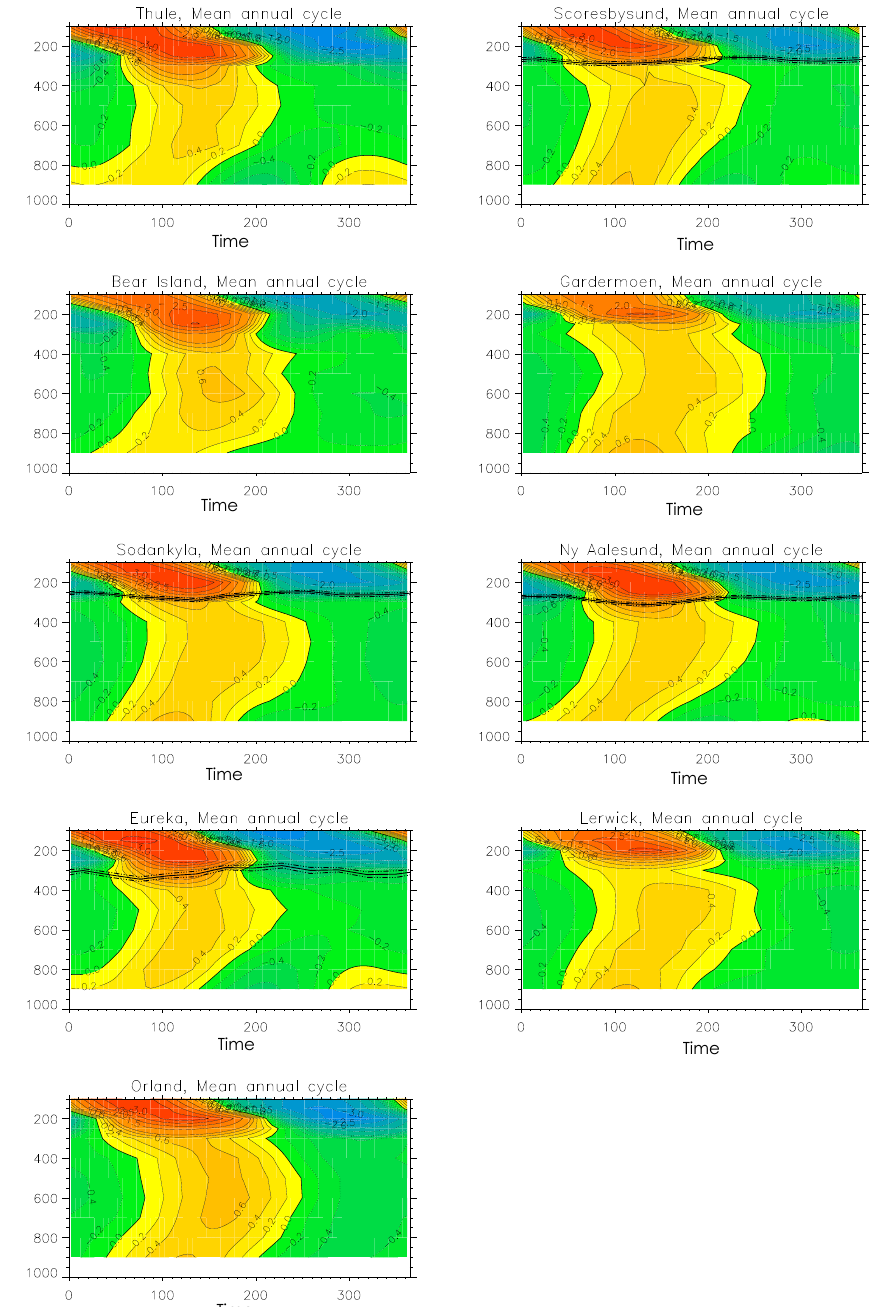
Figure 9. Mean annual cycle as a function of pressure level. Model settings: n pol = 4, n cyc = 2, n a tr = n θ tr = 0, and white noise. For Scores- bysund, Sodankylä, Ny Ålesund, and Eureka the annual cycle of the tropopause is also shown (full black curve) together with its ± 2 σ confidence levels (dashed black